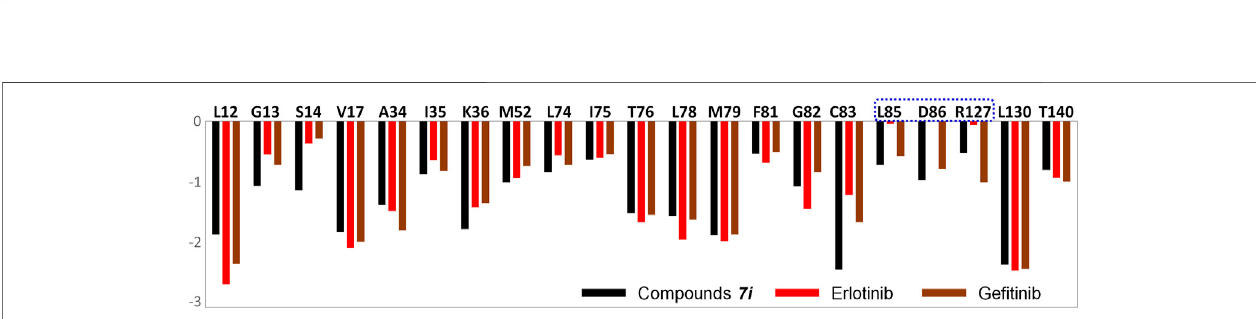
Frontiers in Pharmacology |